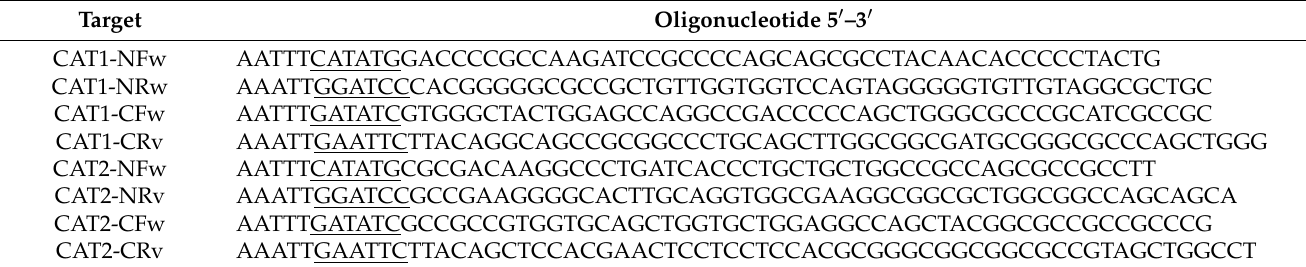
Table 1. Oligonucleotides used to construct targeting peptides of CAT1 and CAT2. Target Oligonucleotide 5 (cid:48) –3